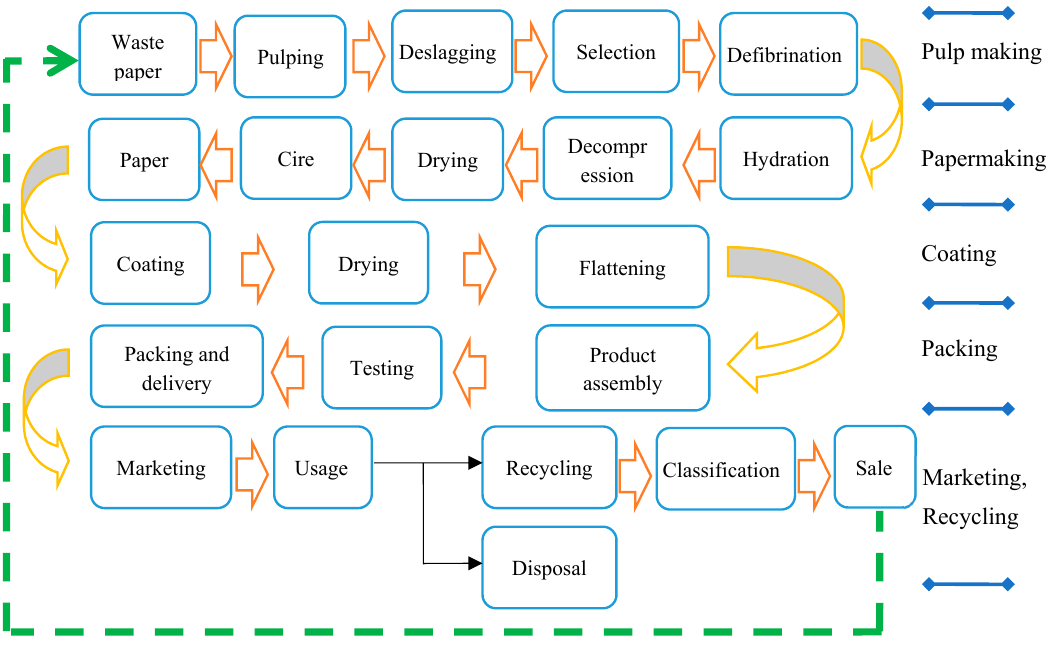
Figure 1. The papermaking process.